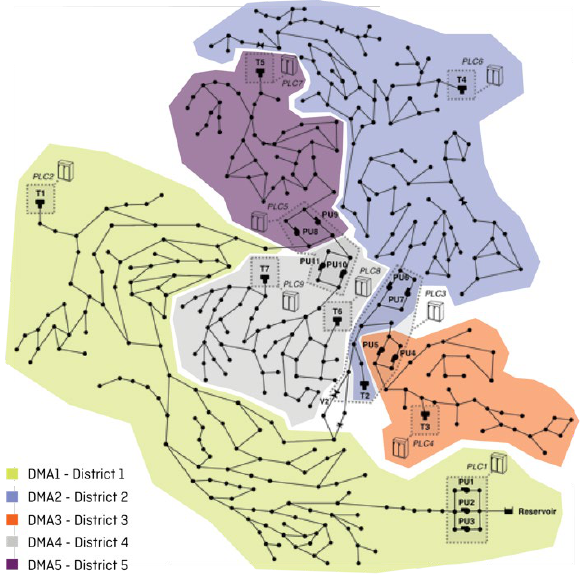
Figure 1 . Map of